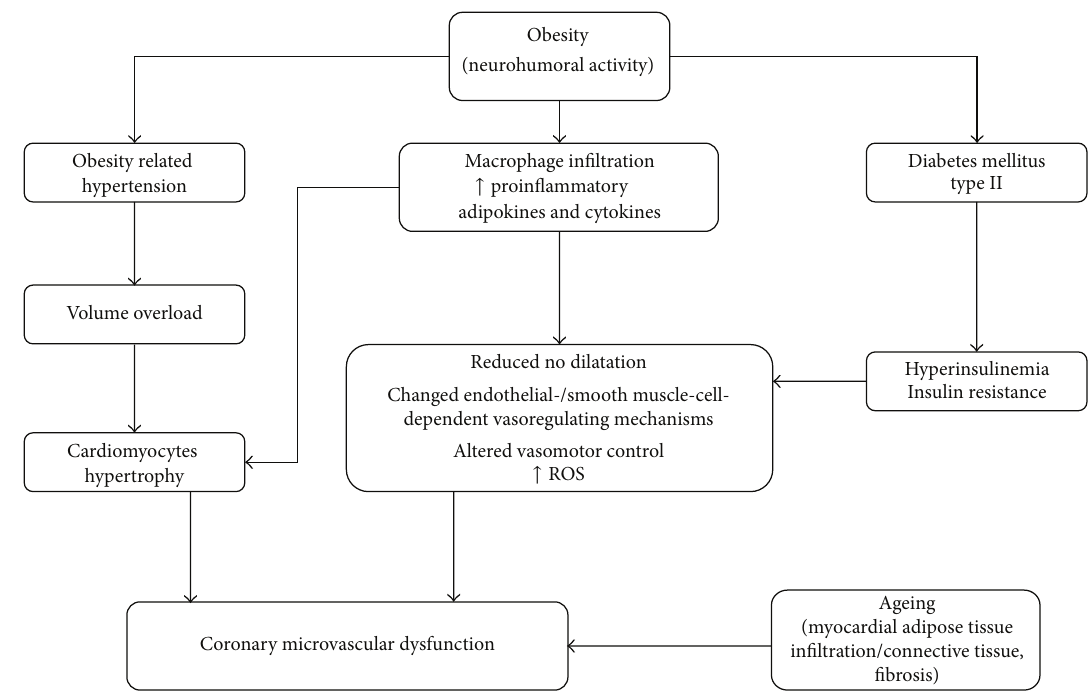
Figure 1: Obesity related coronary microvascular dysfunction